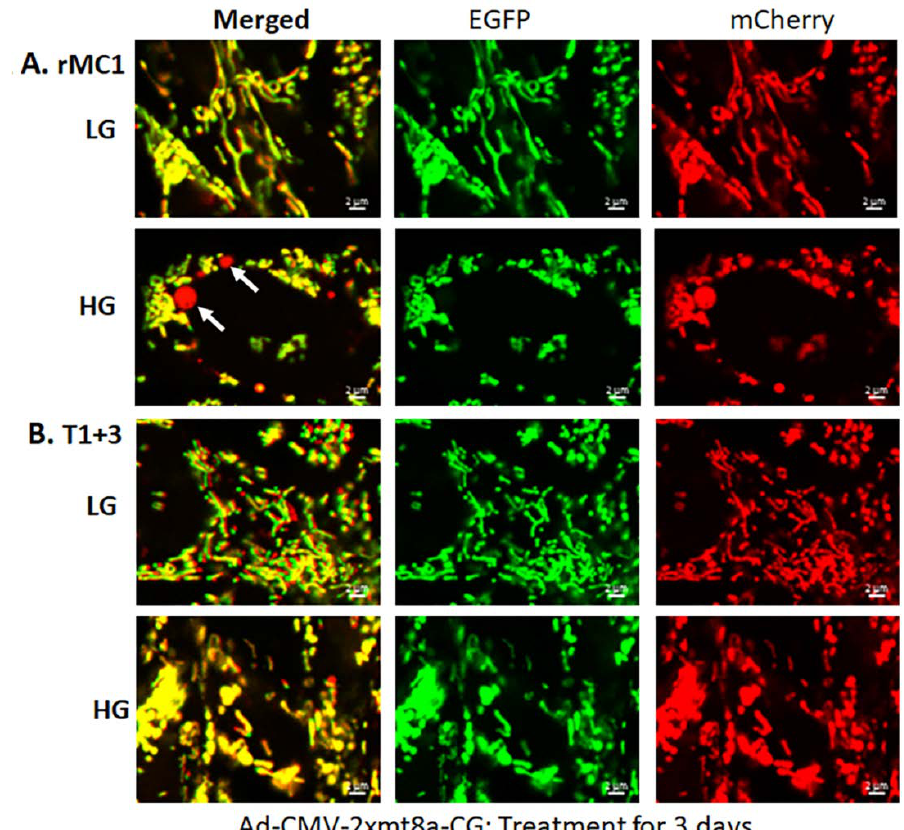
Figure 4. HG induces mitophagy in rMC1 and TXNIP knockout reduces mitophagic flux. ( A ) rMC1 cells were transduced with the mitophagy probe, 2 × mt8a-CG (mCherry/EGFP), for 3 days in the presence of LG or HG. Live-cell confocal imaging shows that HG induces red mitolysosome formation (while arrows) when compared to LG. Active mitochondria emit red and green signals providing a yellow image, while EGFP signal loses in acidic lysosomes after the mitophagic flux. ( B ) TXNIP knockout by CRISPR/Cas9 and gRNA (T1 + 3) prevents mitophagic flux in rMC1 under HG. Images are representation of n = 3, captured by a Zeiss confocal microscope at 630× magnification.